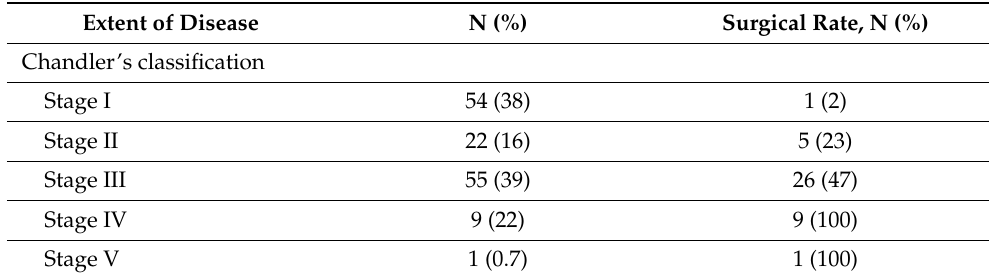
Table 2. Extent of disease